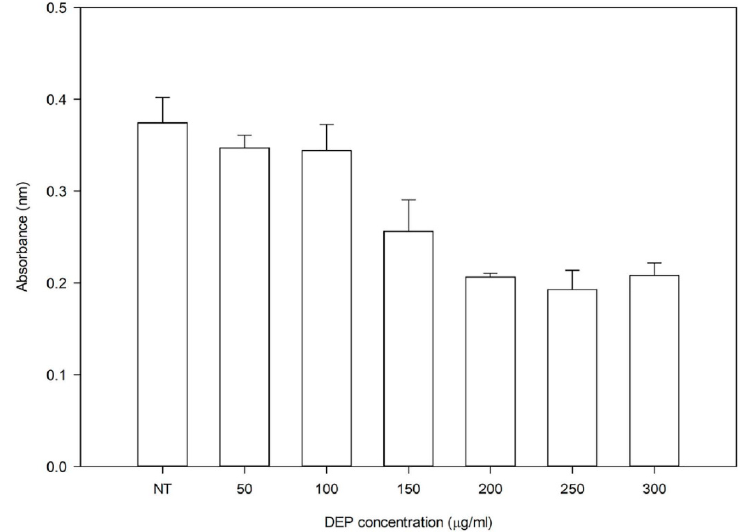
Figure 1. Lactate dehydrogenase assay to determine the diesel exhaust particles (DEP) concentration for experiments. NT is no treatment or DEP concentration at 0